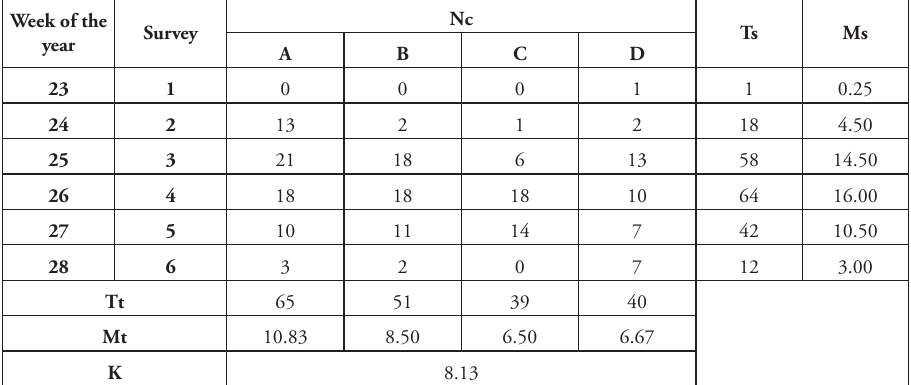
Table 9. Example of data summary and analysis, using the method of sightings along transect at dusk in 2016 at Bosco della Fontana. Number of sightings (Nc) for each transect (A-D) and for each Survey (1-6), total sightings and mean value for survey (Ts, Ms), total sightings and mean value for transect (Tt, Mt) and mean value of sightings for survey and transect (K) are